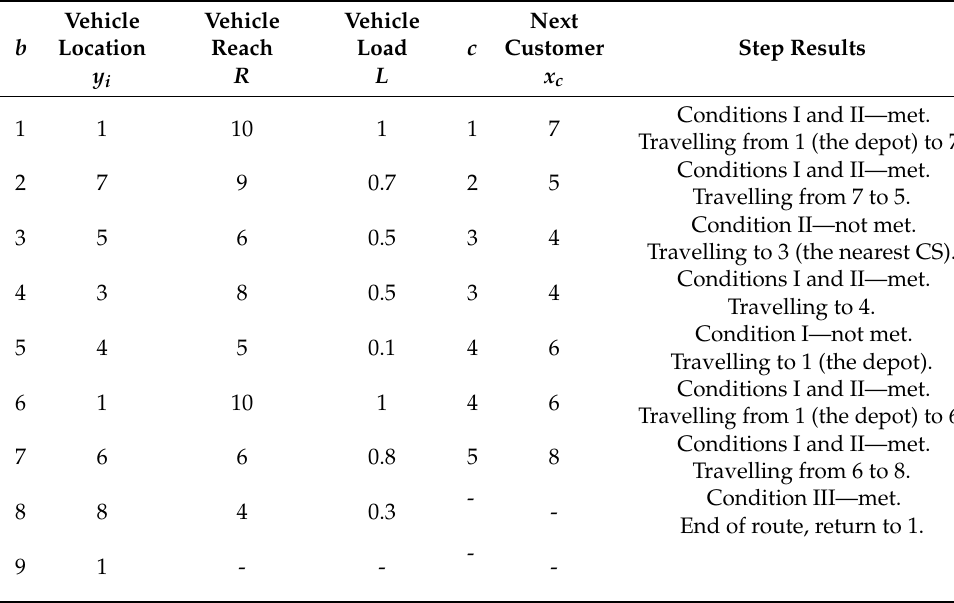
Table 1. Calculation steps of the decoding function.